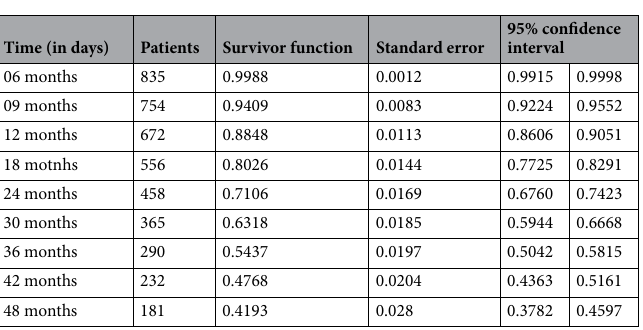
Table 3. Estimated survival from the total sample of 835 patients submitted to primary selective laser trabeculoplasty treatment.